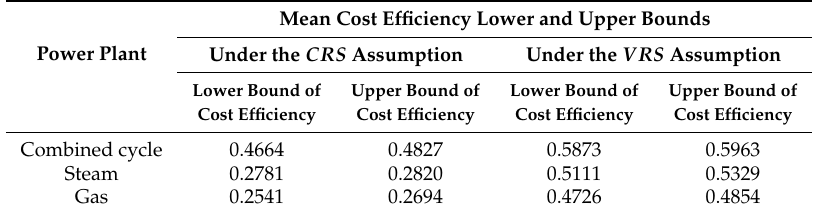
Table 3. Mean cost efficiency lower and upper bounds in terms of the type of power plant in 2015, under CRS and VRS with the semi-disposability